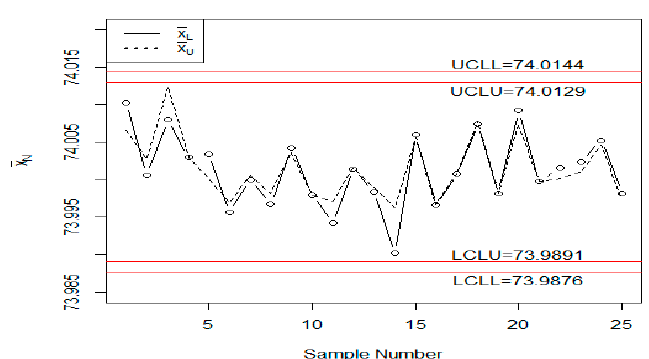
Figure 4. The proposed chart for the real data.